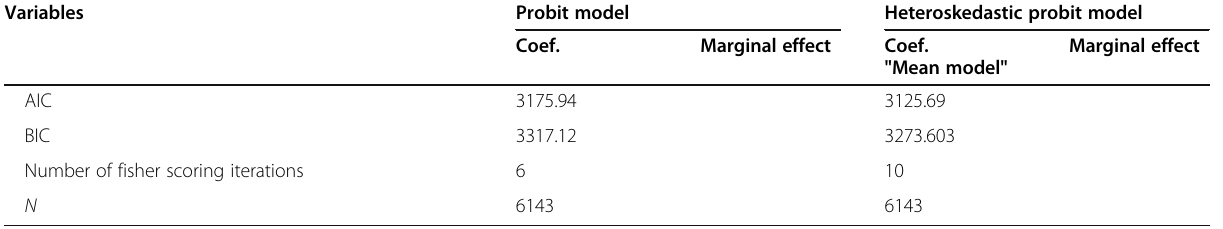
Table 1 Estimates of homoscedastic probit model and heteroskedastic probit model, HIECS, 2015